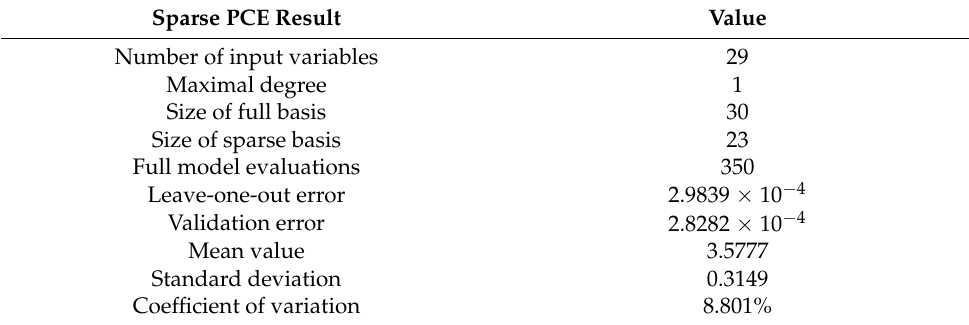
Table 3. Sparse PCE